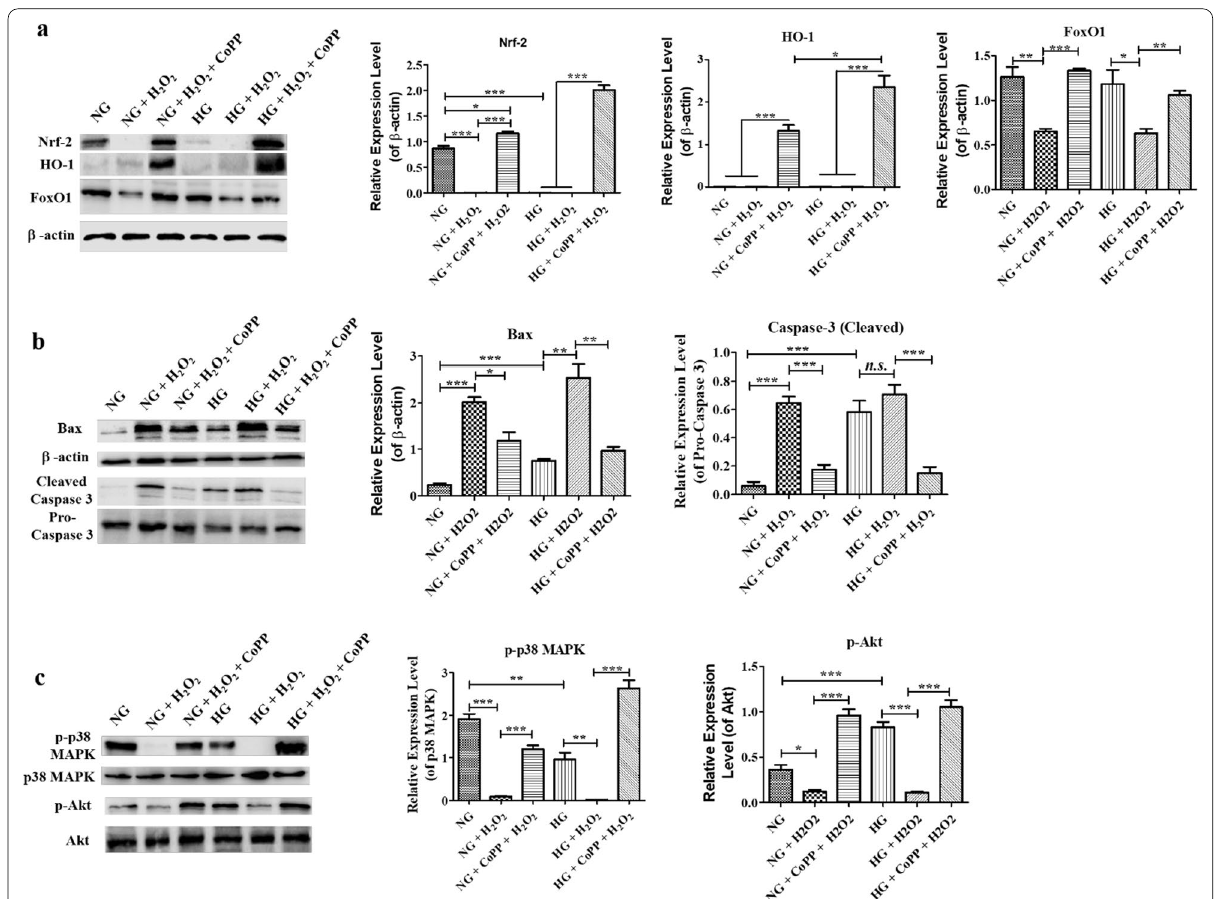
Fig. 5 Western blotting analysis of pro‑apoptotic and anti‑apoptotic protein expressions in CoPP‑pretreated HaCaT in H 2 O 2 ‑containing media. a The protein expression levels of Nrf‑2, HO‑1, and FoxO1. b The protein expression levels of Bax and cleaved caspase‑3. c The protein levels